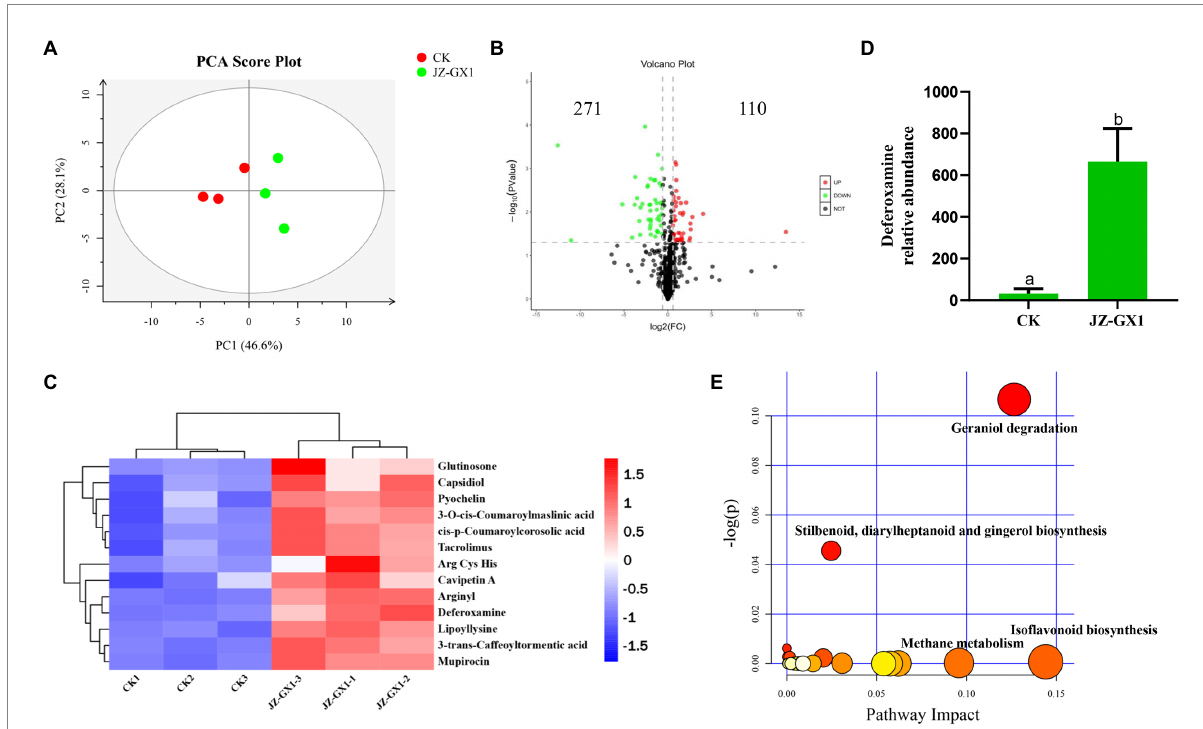
FIGURE 5 PCA analysis of the metabolites for positive mode. PC1 and PC2 are the first two principal components (A) , volcano plot (B) , heatmap analysis for the identified metabolites with significant difference being selected by PLS-DA (VIP >1, p < 0.05) (C) , DFO relative abundance (D) and KEGG pathway analysis of the rhizosphere soil in etiolated and green Cinnamomum camphora. The size and color of each point represents the number of metabolites enriched in a particular pathway and the -log 10 p- values, respectively. A larger pathway impact and − log 10 p -values shows a greater degree of enrichment (E)